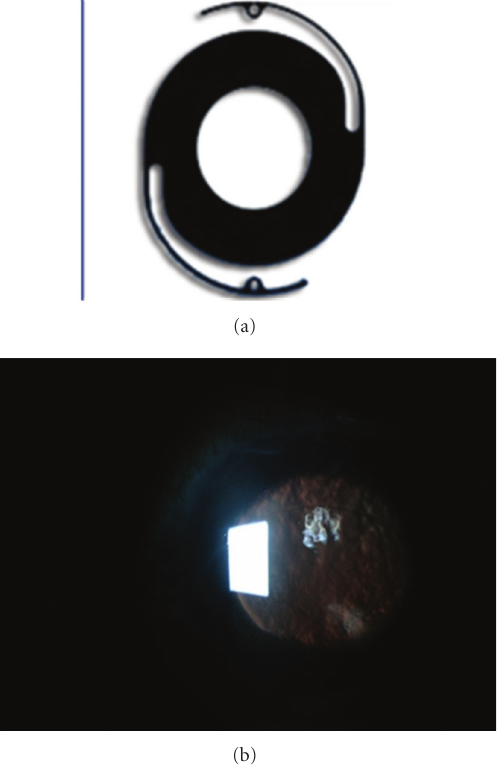
Figure 2: (a) Morcher aniridia Intraocular Lens of +22 diopters and a 5mm pupil zone. (b) Clinical picture using retro illumination after the aniridia IOL implantation demonstrating the jet black reflection out side the central optical zone and corneal